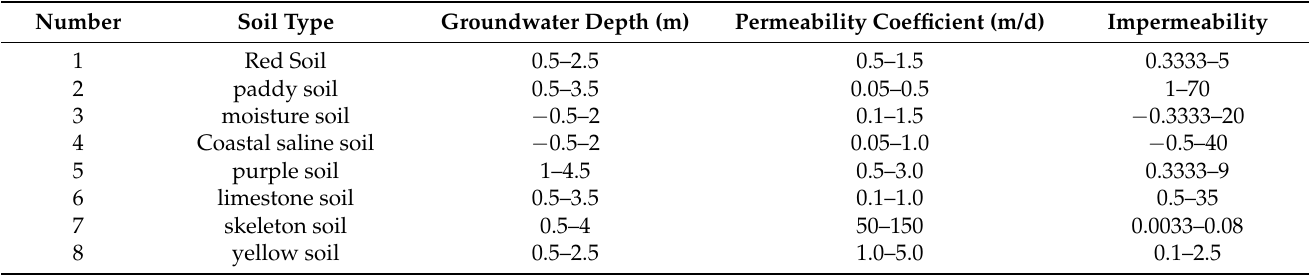
Table 5. Statistical of impermeability degree.